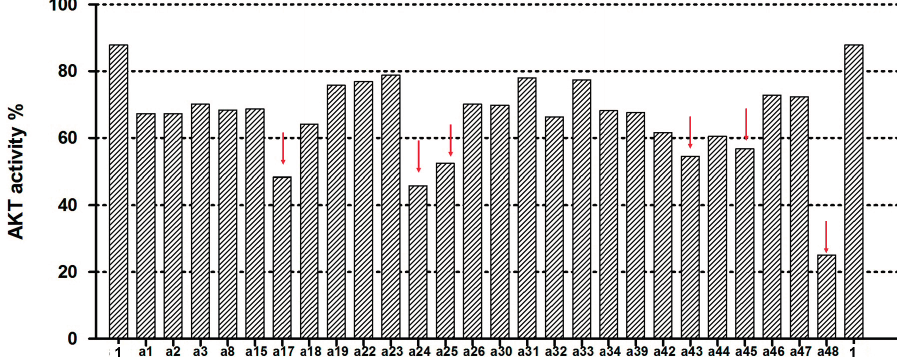
Figure 4. Twenty-six test compounds showed more potent inhibitory effects on Akt kinase than the reference inhibitor H-89 (Compound 1 ). Six of these compounds inhibited Akt kinase to less than 60% residual activity (as indicated by the downward arrow).